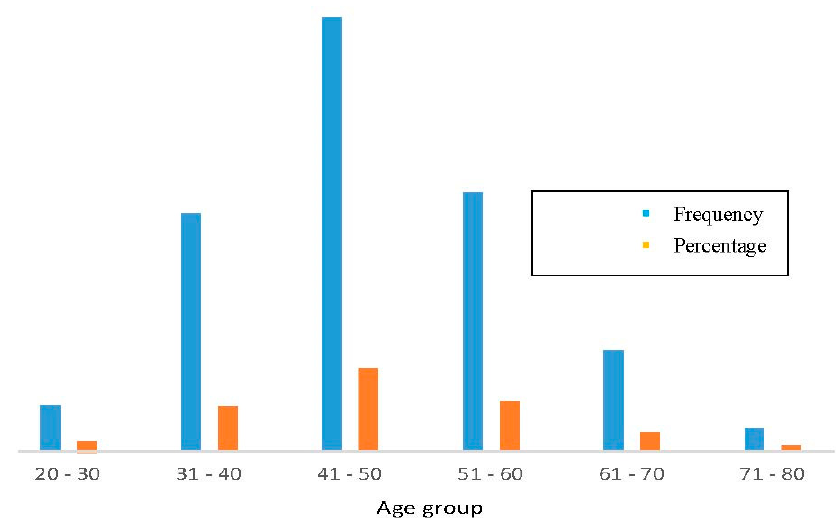
Figure 3. Incidence of cervical cancer in different age groups. Highest rate in 41-to-50-year-old group, and lowest in 71-to-80-year-old group. Green indicates frequency and brown indicates percentage. Most susceptible age group is 41–50 years; females in 31-to-40-year-old and 51-to-60-year-old groups had same ratio of cancer in Bangladesh.